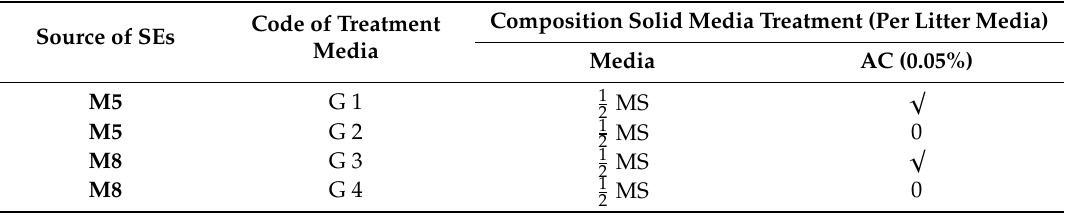
Table 10. The treatments composition during the germination phase.